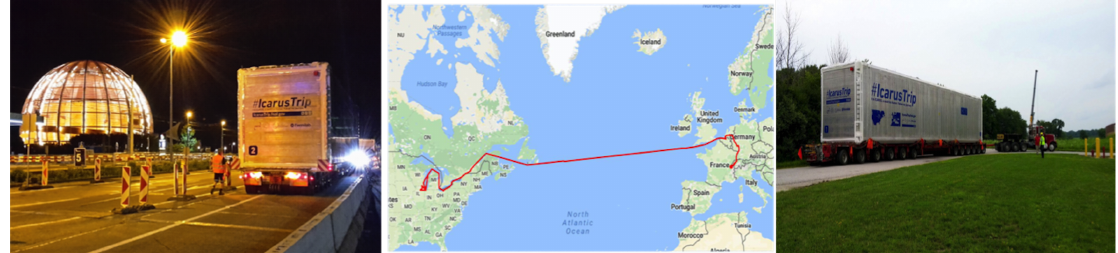
Figure 5. The so called icarustrip, the journey of the T600 detector from CERN to FNAL. In particular, on the left is a picture of the T600 detector leaving from CERN on 12 June 2017. In the middle, the map of the long journey of the detector, and finally, on the right, a picture of the T600 arriving at the SBN Far site building in Fermilab on 26 July